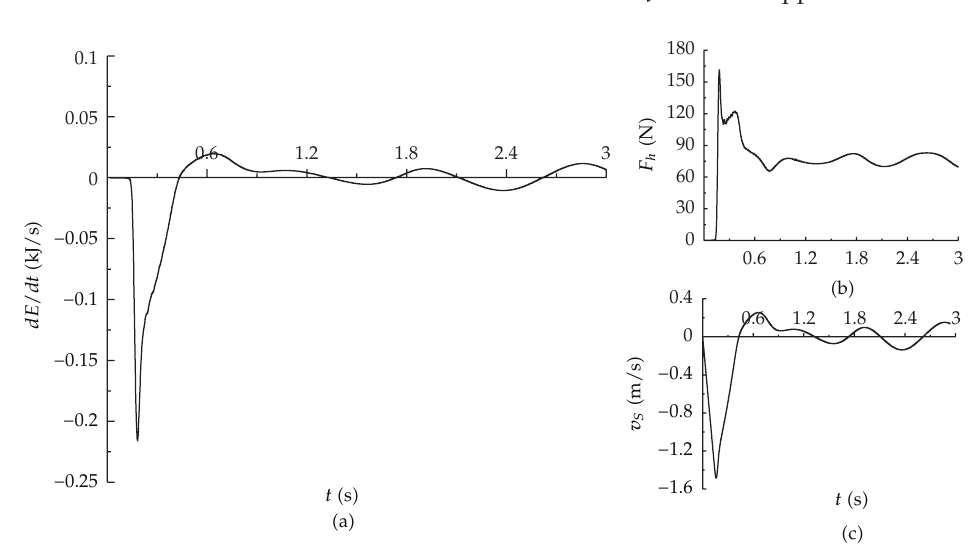
Figure 3: Time histories of variation rate for total energy (cid:2) a (cid:3) , hydrodynamic (cid:2) b (cid:3) , and velocity (cid:2) c (cid:3) of free- falling